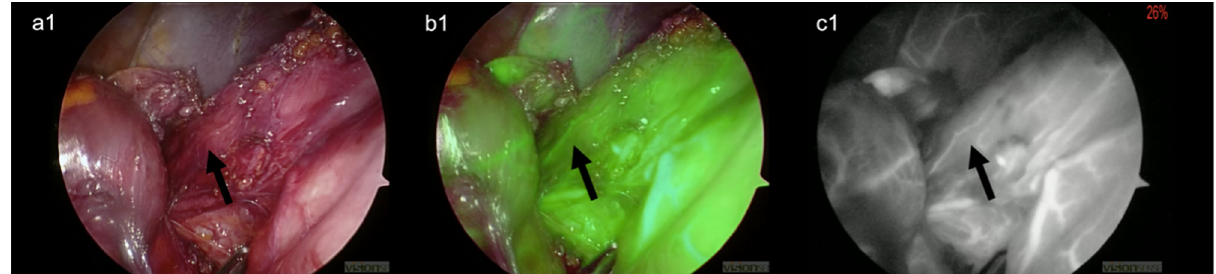
Figure 4. Evaluation of the remaining vascular supply of the esophagus (arrow). ( a1 ) Visible-light image ( b1 ) green filter image ( c1 ) near-infrared (NIR) image.